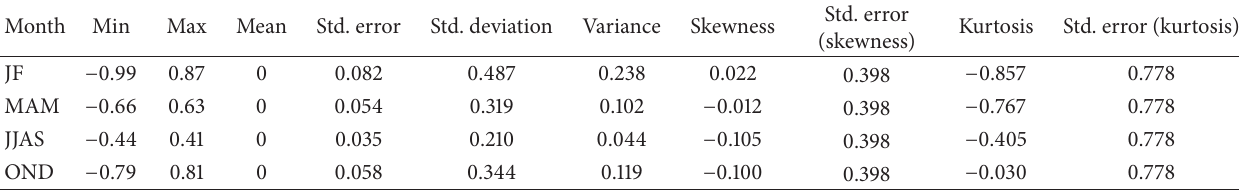
Table 3: General statistics of temperature at 925 hPa.